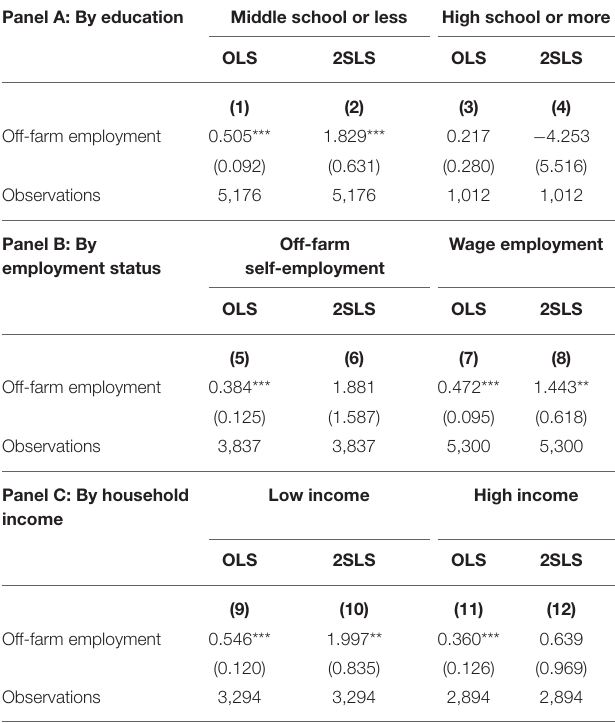
TABLE 5 | Results by education, employment status and household income. Panel A: By